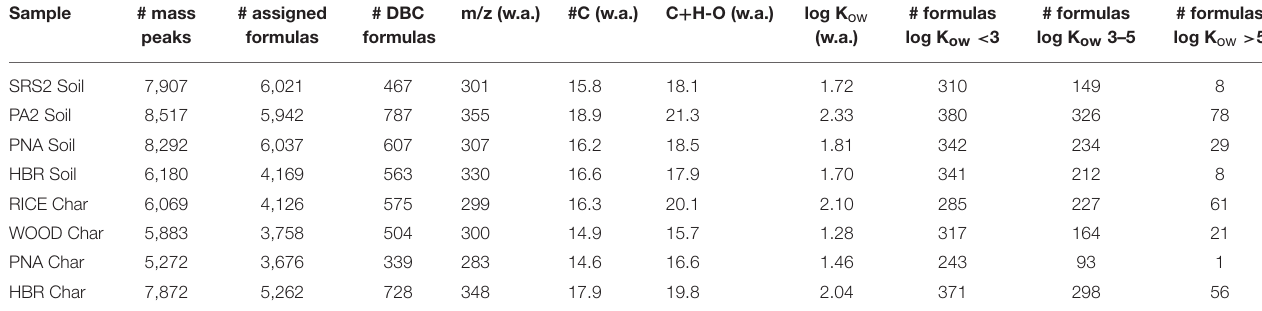
TABLE 4 | FT-ICR mass spectral data for soils and chars leached with deionized water.